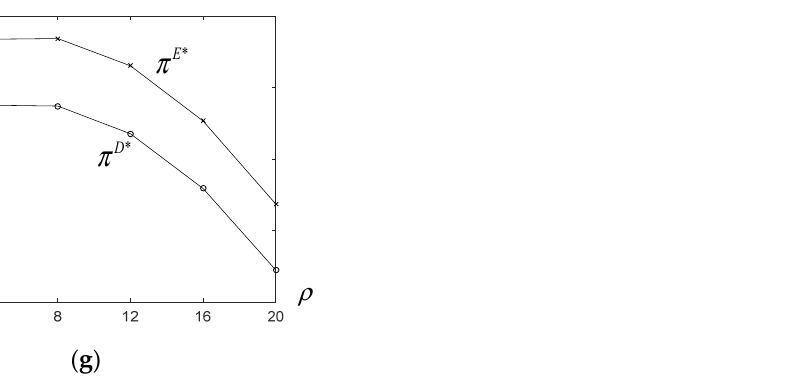
Figure 3. Graphs of the changes of each variable in the extended model and the basic model without altruistic preference: ( a ) the changes of 𝒔 over ρ ; ( b ) the changes of 𝑝 over 𝜌 ; ( c ) the changes of ℎ over 𝜌 ; ( d ) the changes of 𝑞 over 𝜌 ; ( e ) the changes of the manufacturer profits over 𝜌 ; ( f ) the changes of the e-platform’s profit over 𝜌 ; ( g ) the changes of the systems’ profits over 𝜌 . As can be seen from Figure 3, when 𝜌 ∈ (cid:4670)0,20(cid:4671) , in the extended model and the basic